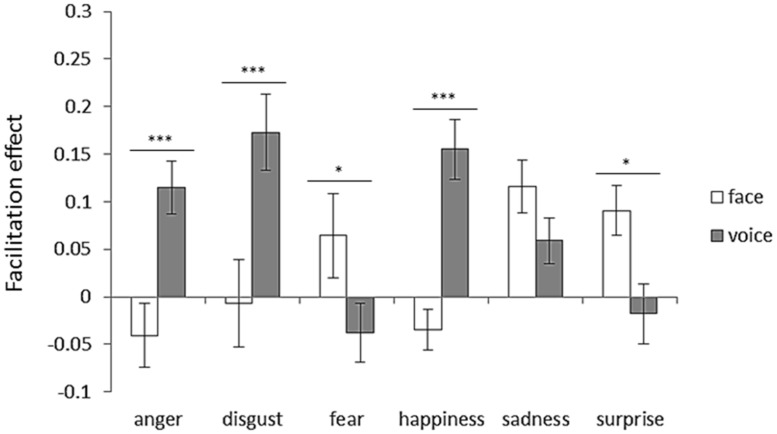
Facilitation effect for each emotion category with respect to attended modality. Error bars represent SE. Asterisks indicate significant differences between attended modalities (*p < 0.05, ***p < 0.001). “V > A” in Table 3 was the case that the bar length of the face was shorter than that of the voice, and “A > V” in Table 3 was the case that the bar length of the voice was shorter than that of the face.